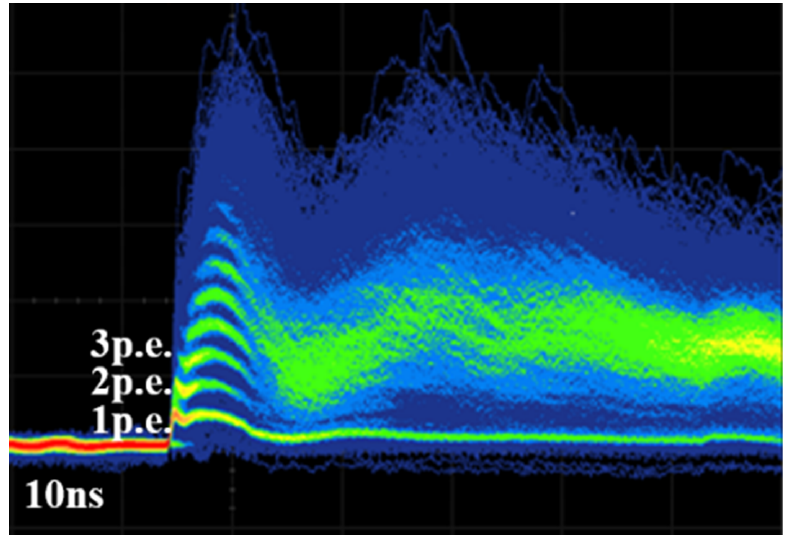
Figure 5. SiPM output signal measured by the oscilloscope in glow mode.